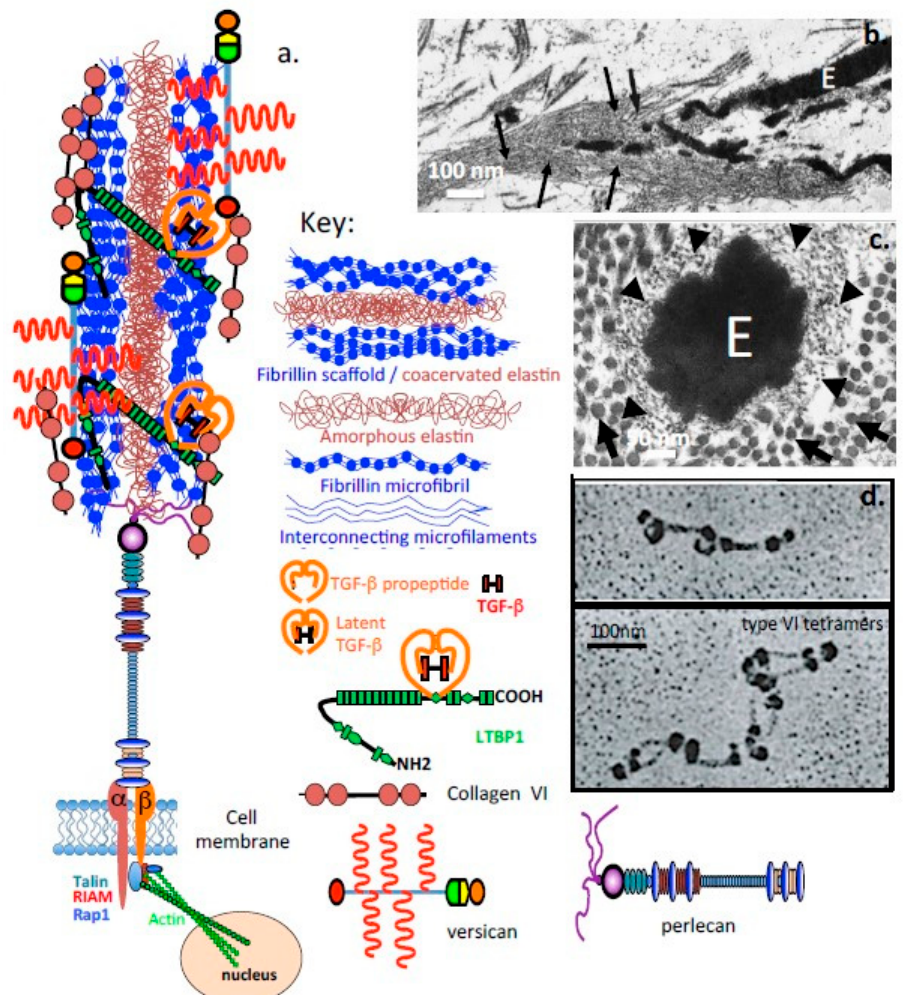
Figure 4. Schematic depiction of the elastic microbril, containing perlecan and fibrillin as functional omponents. ( a ) Sche- matic depiction of an elastic microfibril and its components. Electron micrographs of tannic acid-glutaraldehyde-fixed samples demonstrating the central amorphous elastin (E) within a microfibril in ( b ) longitudinal (magnification × 18,000) and ( c ) cross-section (magnification × 85,000); ( d ) Rotary shadowing images showing the characteristic interrupted globular domains in type VI collagen. Segment b, c reproduced from [55]. Segment d [56] under Open Access. Arrows in ( b ). depict microfibrillar material, E amorphous elastin. Arrowheads in ( c ). depict microfibrils in cross section, whilst arrows indicate collagen fibres in cross section .